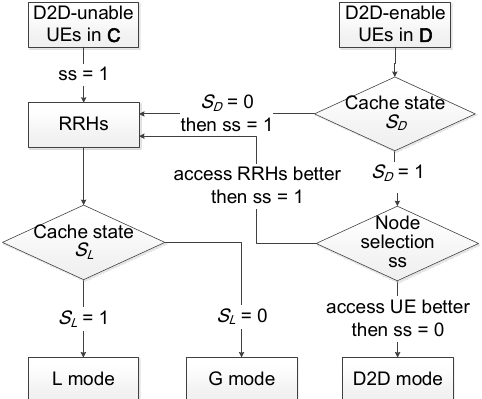
Fig. 2. An illustration of mode selection for UE k in F-RAN at slot t in subchannel n under given cache state S L S D . Note that when S D = 1 , D2D pairs need to make a performance comparison between accessing RRHs and